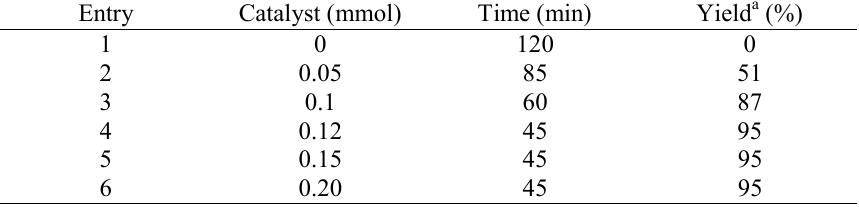
Table 1 . The effect of amount of DBH on the reaction of o -phenylenediamine and benzaldehyde under thermal solvent free conditions.